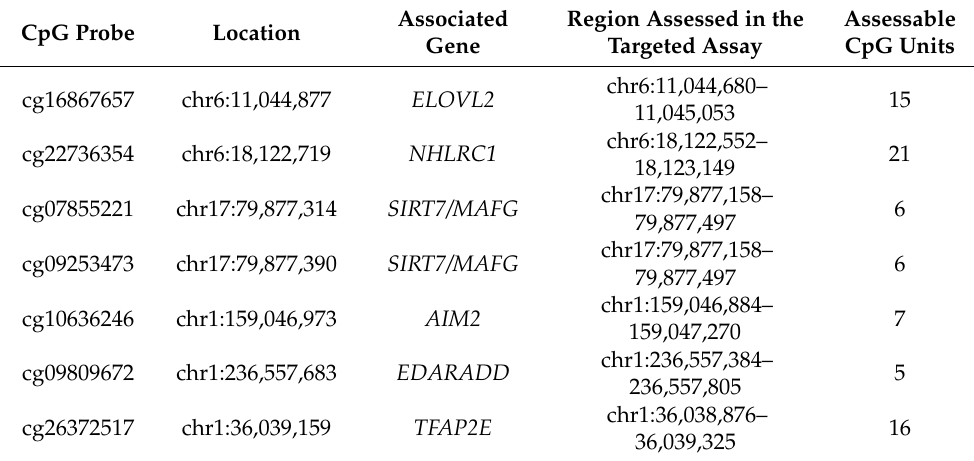
Table 3. CpG probes and genomic regions assessed in the targeted epigenetic clock. CpG Probe Location